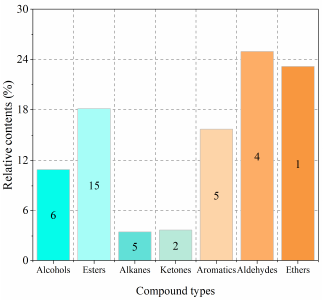
Figure 2. Contents of compound types in strawberry volatiles is presented with columns in different colors. The figure on the column means the number of compounds of this type . Table 2. Number and relative content (% of each compound) of the compounds identified in ‘Red Face’ flower volatiles. Types/No.